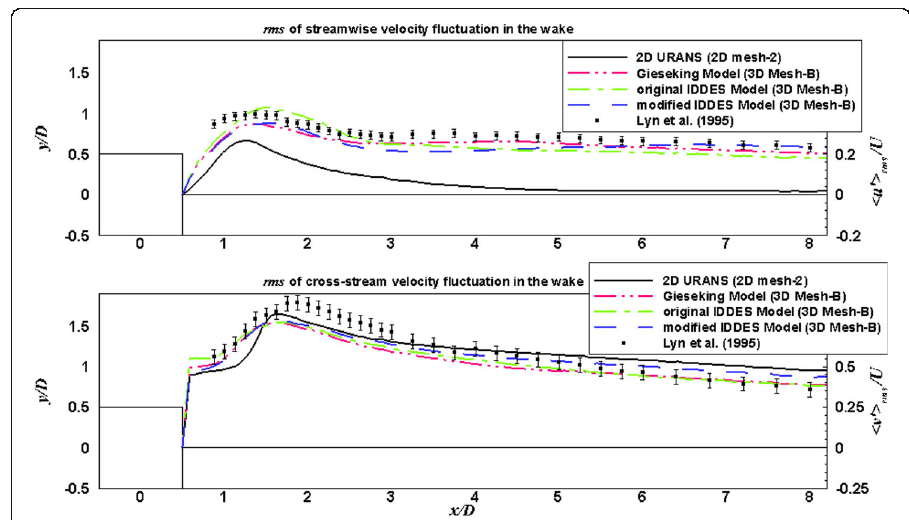
Fig. 7 rms streamwise (top) and cross-stream (bottom) velocity fluctuations along the wake centerline predicted by simulations with URANS model and 3D